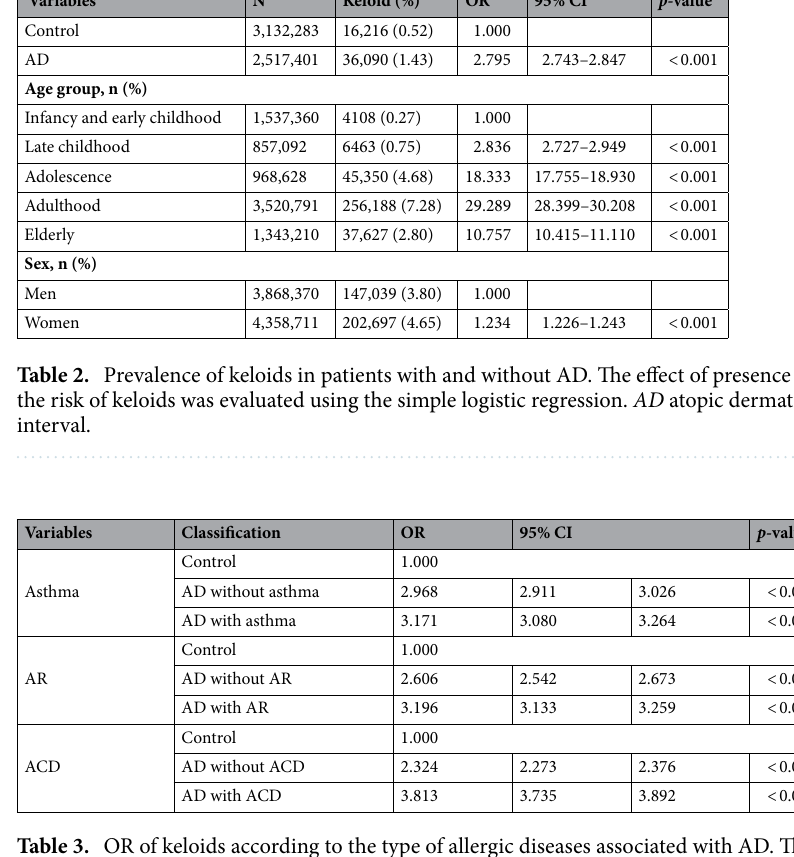
Table S2 online.